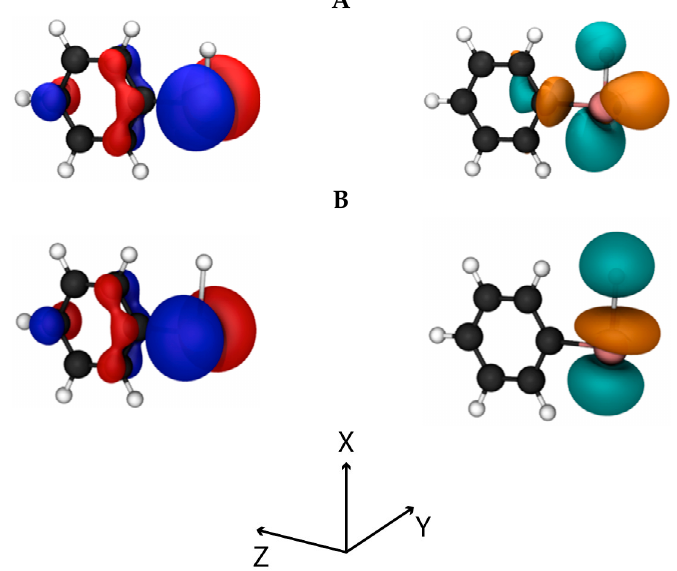
Figure 3. ( A ) HOMO (left) and LUMO (right) orbitals of PhTeH. ( B ) HOMO (left) and LUMO (right) orbitals of PhTeH at the maximum imposed deformation of the Te–H bond (2.66 Å). Isodensity 0.05 a.u. Level of theory: